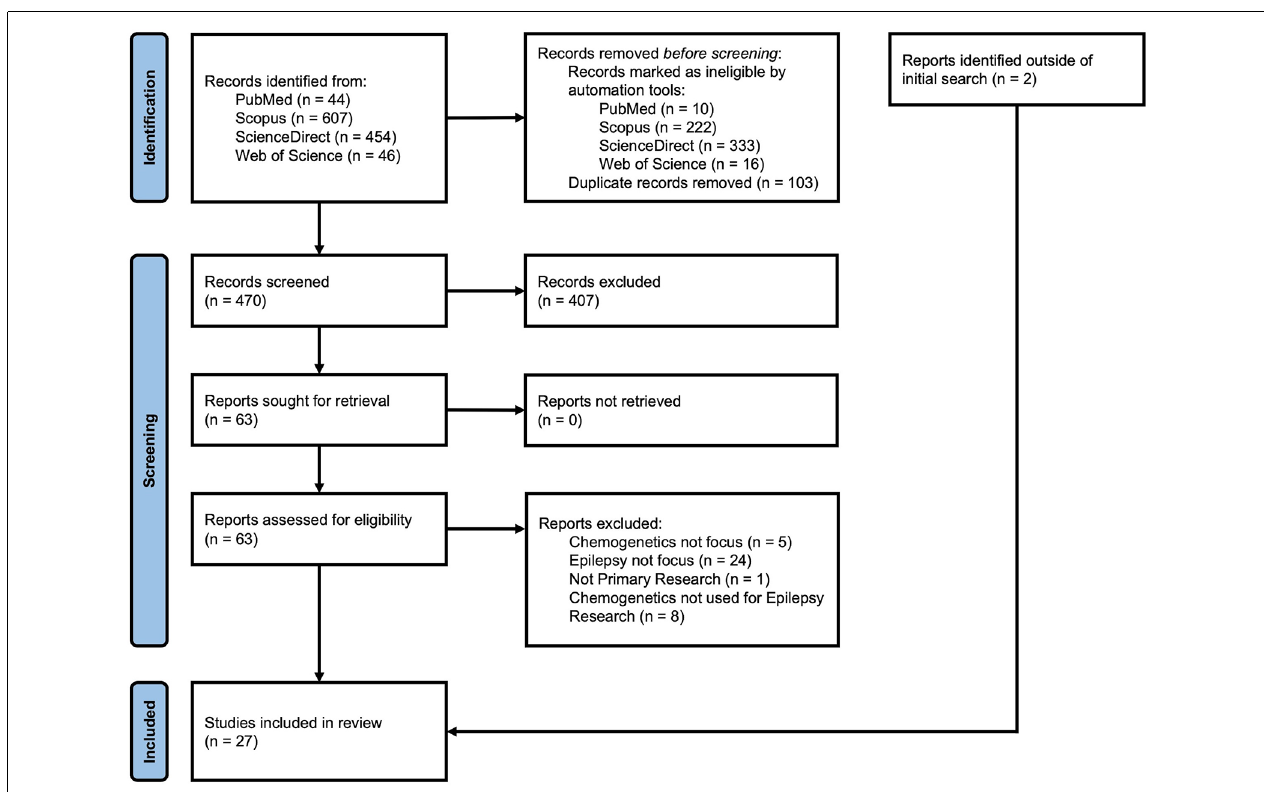
FIGURE 2 | PRISMA flow diagram of record identification, screening, and inclusion process for this